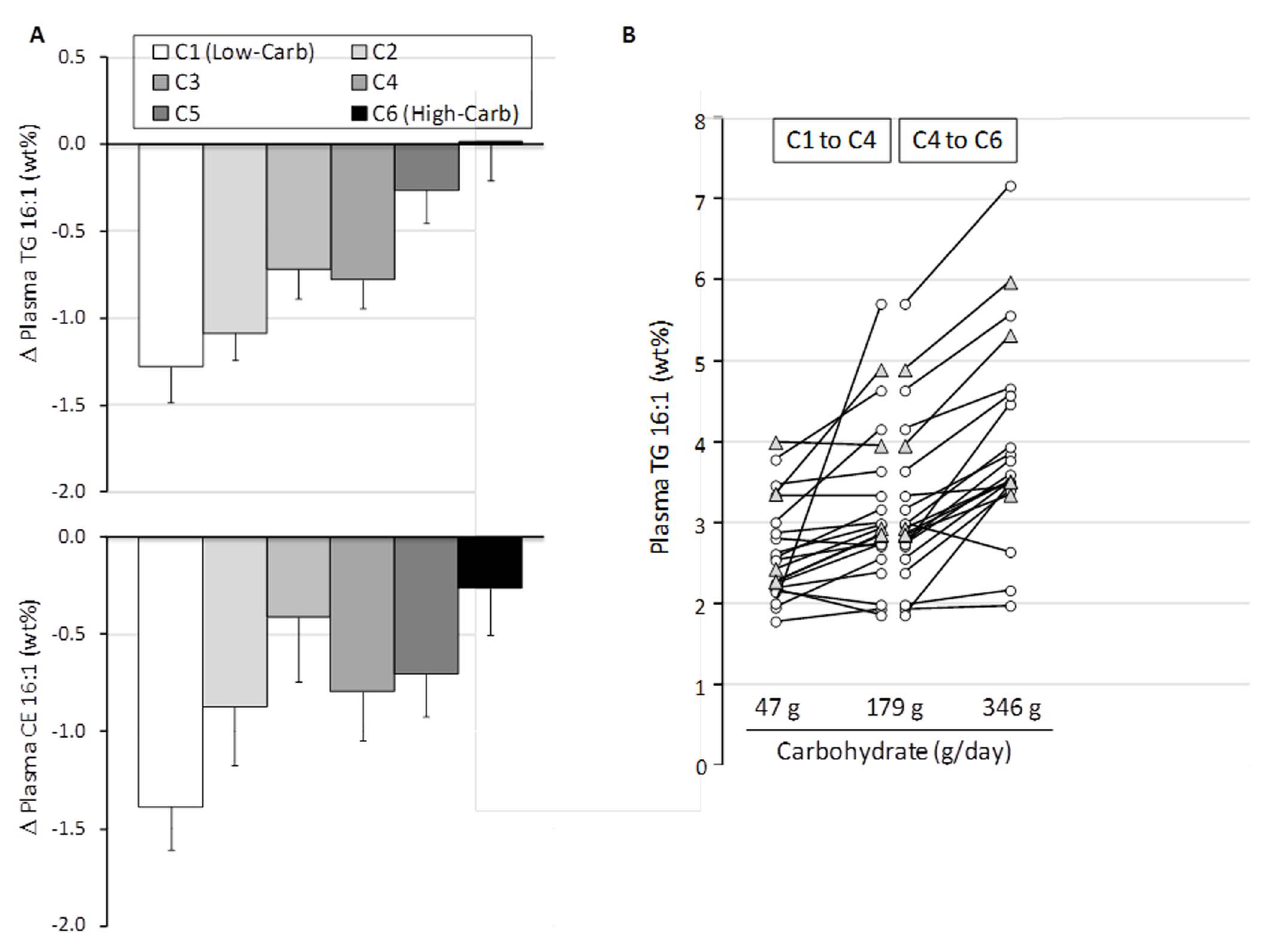
Figure 3. ( A ) Change from baseline in plasma palmitoleic acid (16:1) in triglyceride (TG) and cholesteryl ester (CE) in subjects who consumed a very low carbohydrate diet (C1) and then gradually transitioned to a high carbohydrate diet over six sequential phases (C1 R C2 R C3 R C4 R C5 R C6). ( B ) Individual responses in plasma TG 16:1 from C1 to C4 to C6 corresponding to 47, 179, and 344 g carbohydrate/day. Open circles are subjects who went from low- to high-carbohydrate, and shaded triangles are subjects who went from high- to low-carbohydrate